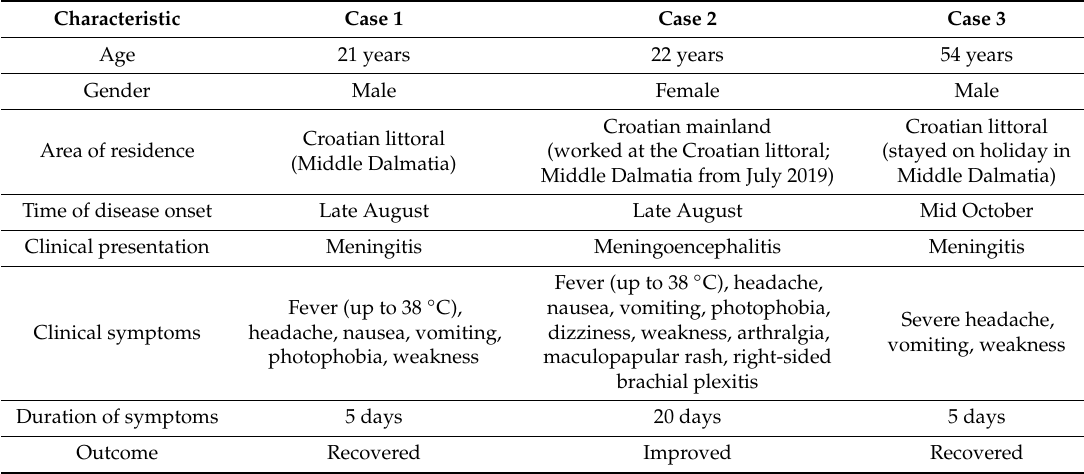
Table 1. Epidemiological and Clinical Characteristics of Patients with Toscana Neuroinvasive Infection. Characteristic